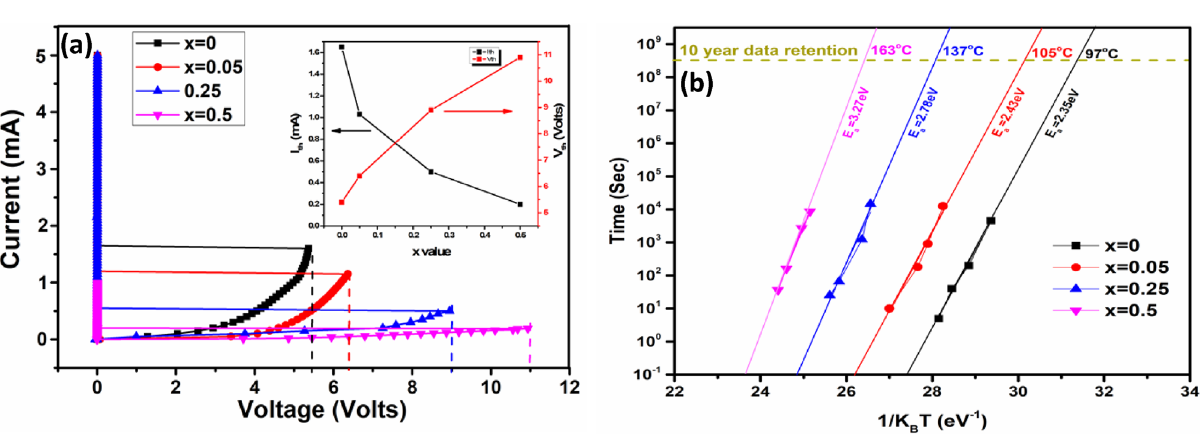
Figure 8. ( a ) I–V characteristics of GeTe 1−x Se x films. The inset shows the dependence of I th and V th on the Se concentration. ( b ) Data Retention measurement for corresponding